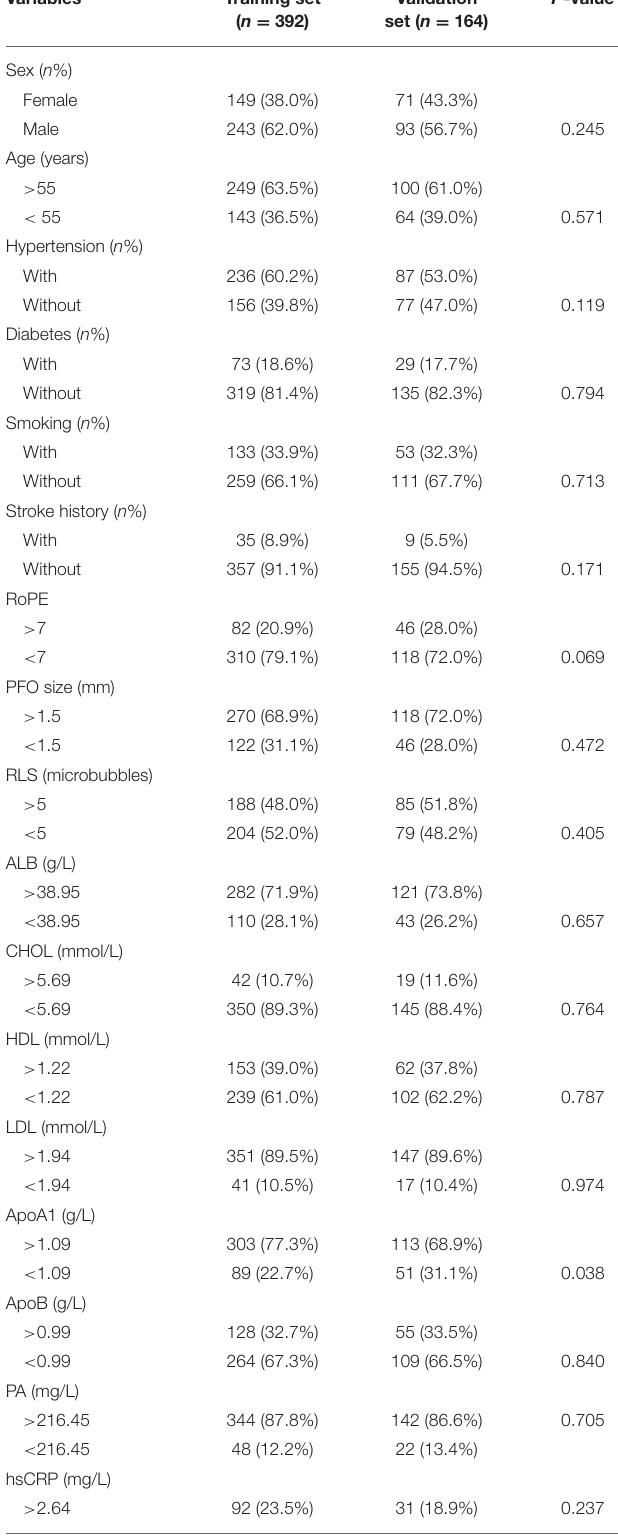
TABLE 1 | Characteristics of patients in the training and validation